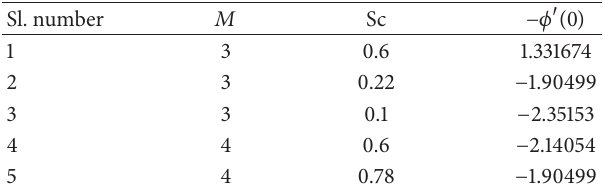
Table 3: Values of Sherwood number −𝜙 󸀠 (0)